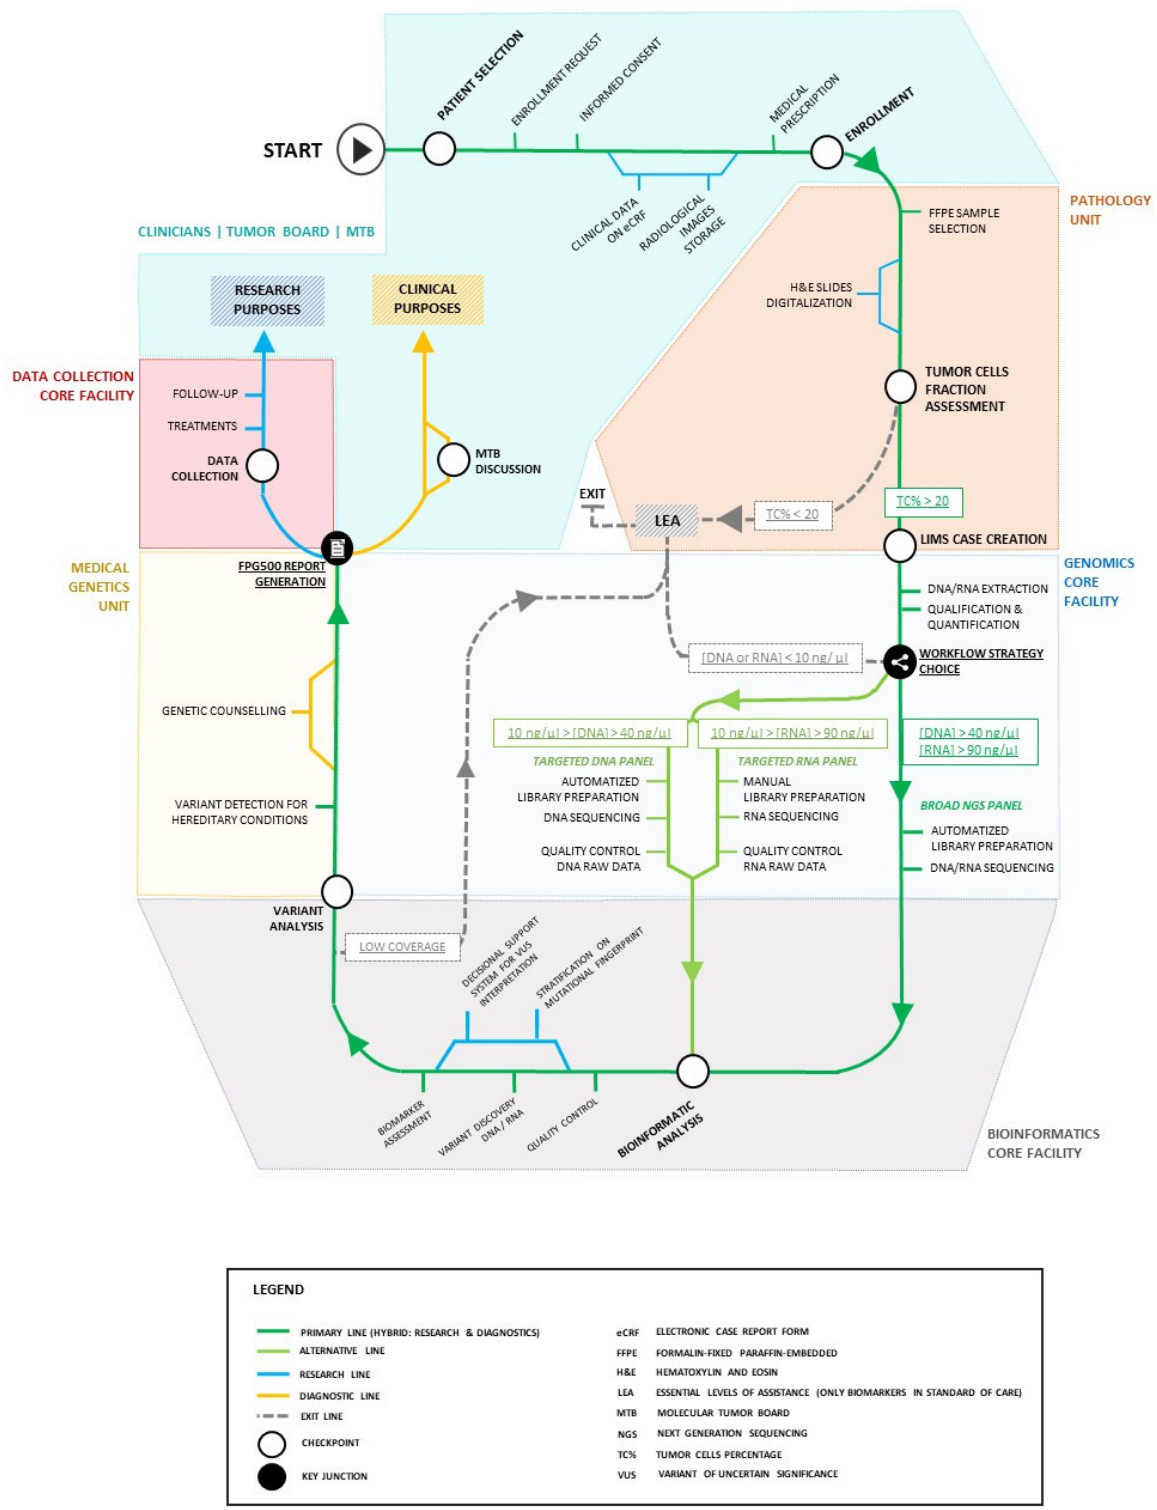
Figure 1. CGP Figure 1. CGP journey.